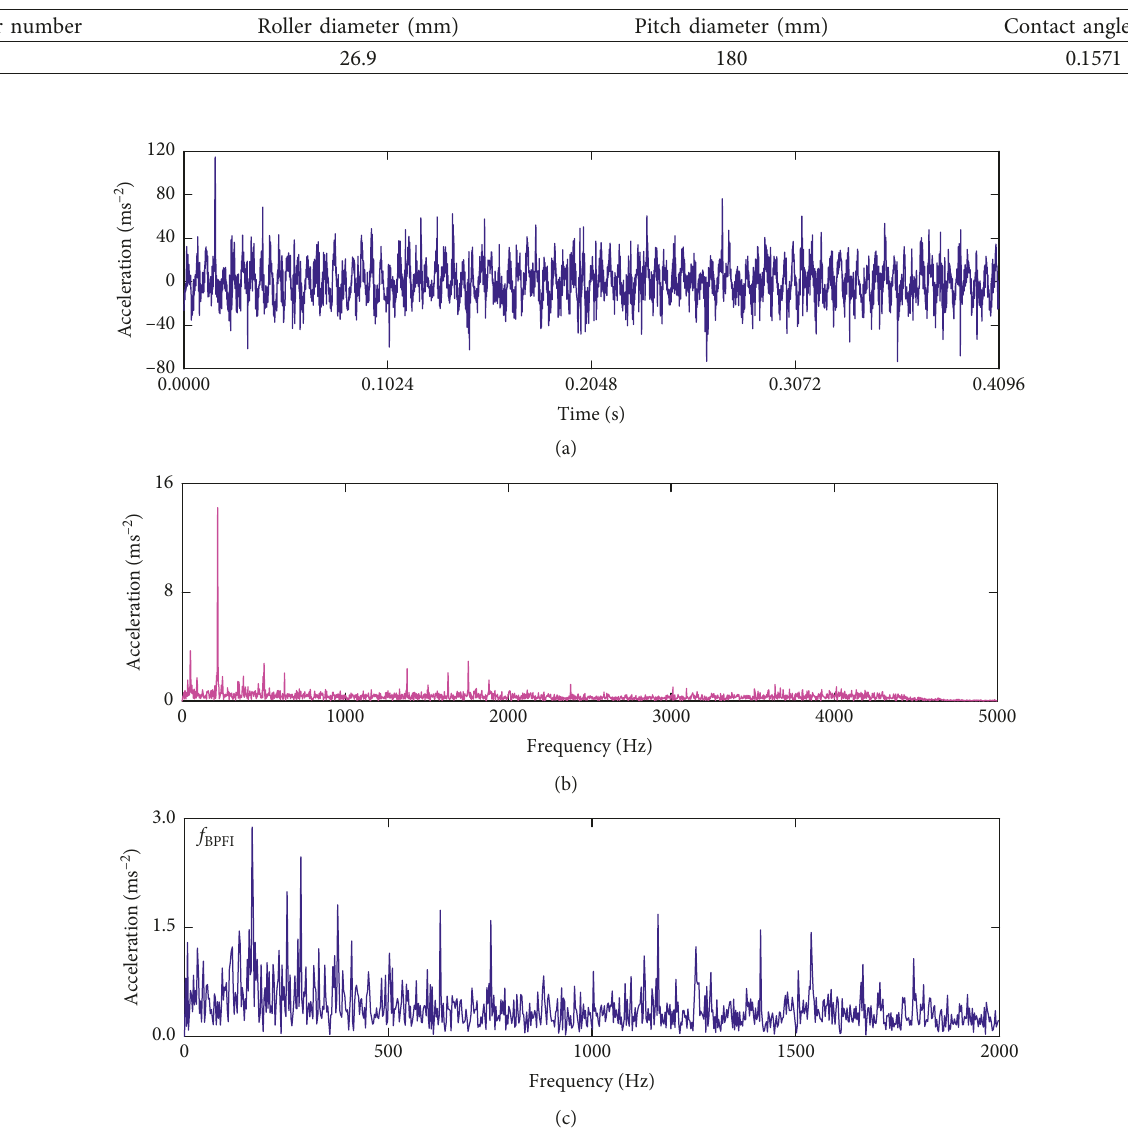
Table 6: Rolling bearing test parameters.